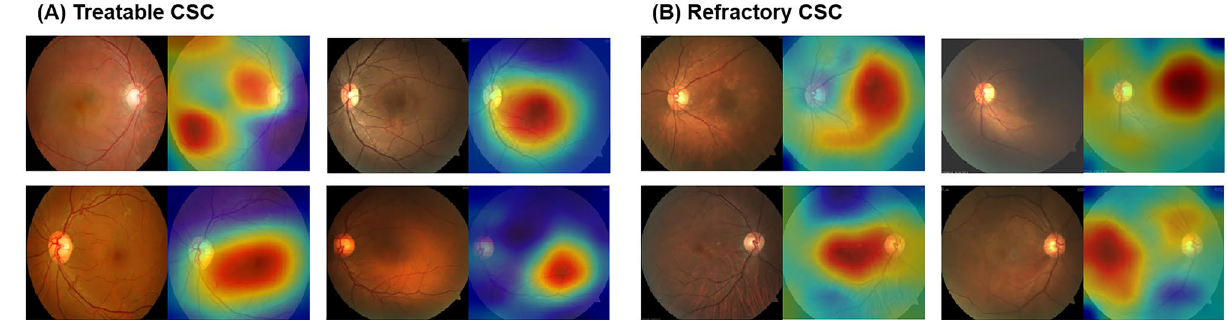
Figure 4. Representative gradient-weighted class activation mapping (Grad-CAM) heatmaps of fundus photography of central serous chorioretinopathy (CSC) eyes from the ( A ) treatable (complete absorption of subretinal fluid) and ( B ) refractory (retention of subretinal fluid) groups after photodynamic